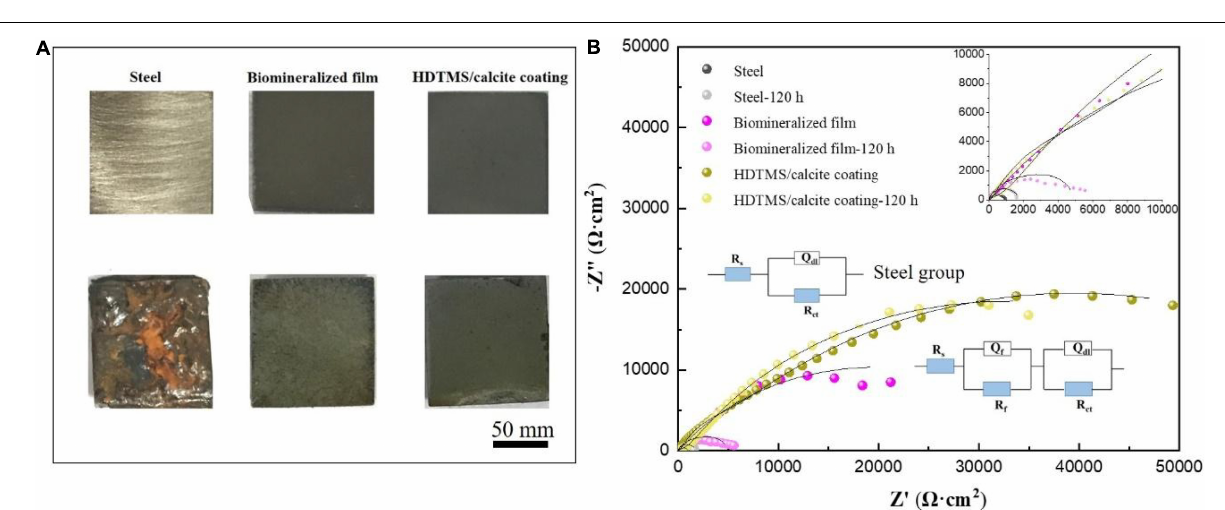
FIGURE 10 | (A) Corrosion morphology images and (B) electrochemical impedance spectroscopy (EIS) plots of the steel, biomineralized film, and HDTMS/calcite coating before and after 120 h of acetic acid salt spray